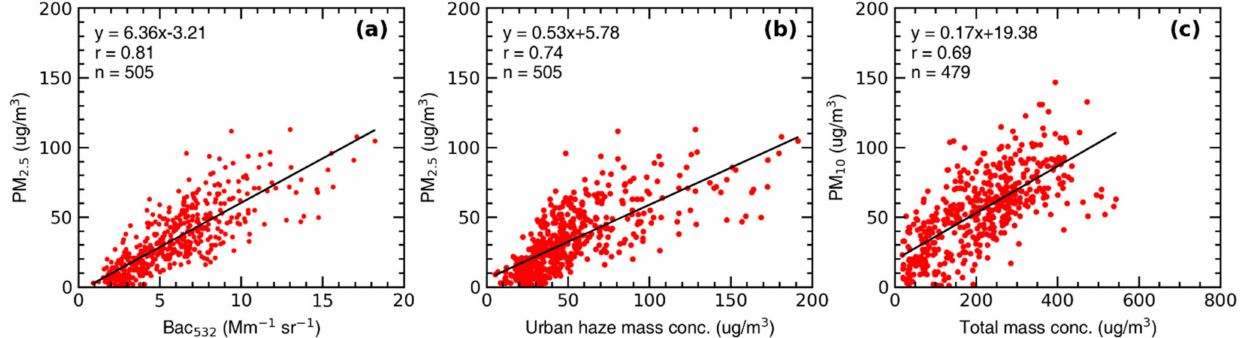
Figure 3. Scatter plots show the correlation between the ( a ) hourly average Bac 532 at 250 m and surface PM 2 . 5 , ( b ) hourly average urban haze mass concentrations at 250 m and surface PM 2 . 5 , and ( c ) hourly average total mass concentrations at 250 m and surface PM 10